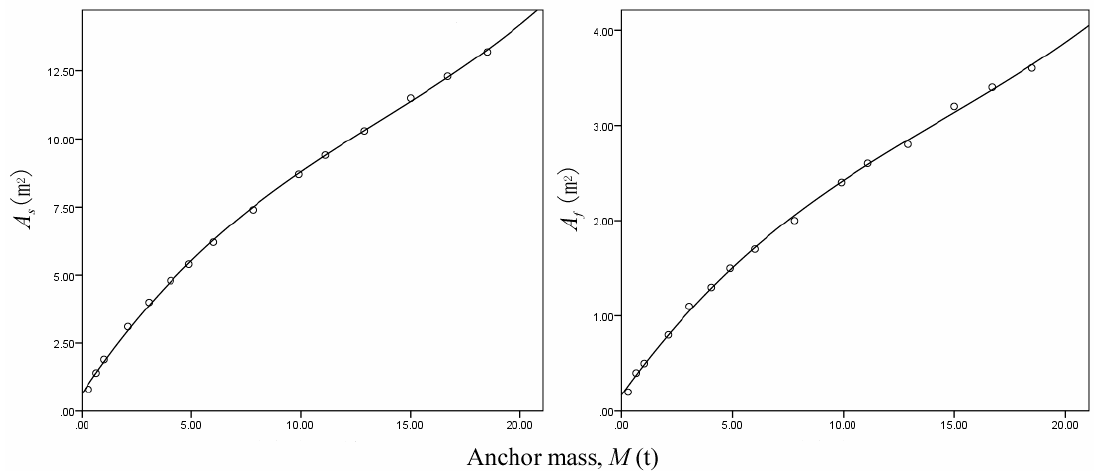
Figure 2. Fitting relationship of A f and A s with M.